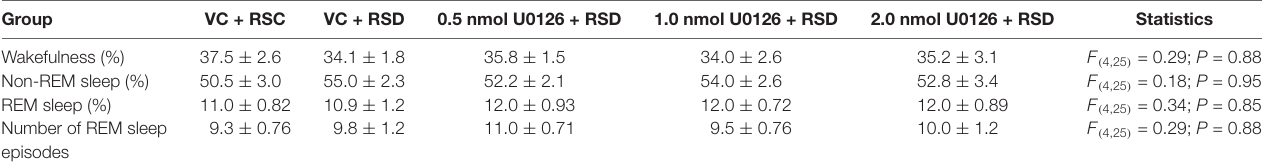
TABLE 1 | The total percentages (mean ± SEM) of time spent in wakefulness, non-REM sleep and REM sleep and total number of REM sleep episodes in five different groups of rats ( n = 6 rats/group) in the 3-h baseline sleep-wake recording session (undisturbed recordings from 10:00 A.M. to 1:00 P.M.). Group VC + RSC VC +